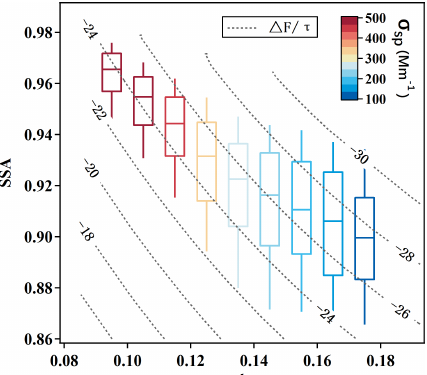
Figure 13. Relationship of SSA with the backscatter fraction and the radiative forcing efficiency at λ = 525nm depicted with the RFE = (cid:49)F/τ isolines in Wm − 2 .